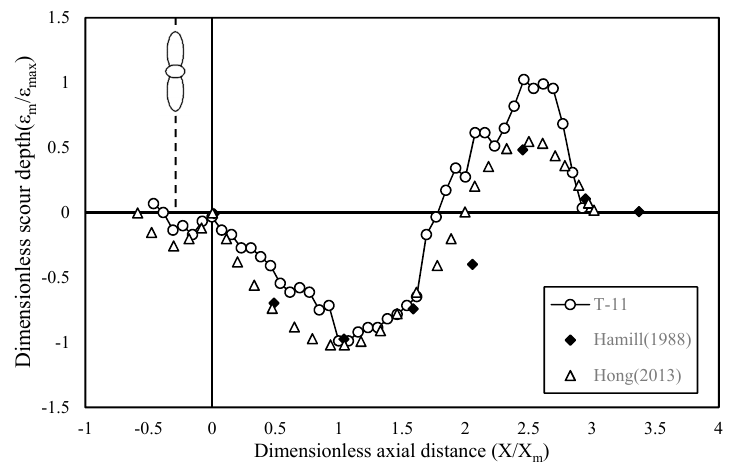
Figure 8. Dimensionless scour profiles for a single-propeller.